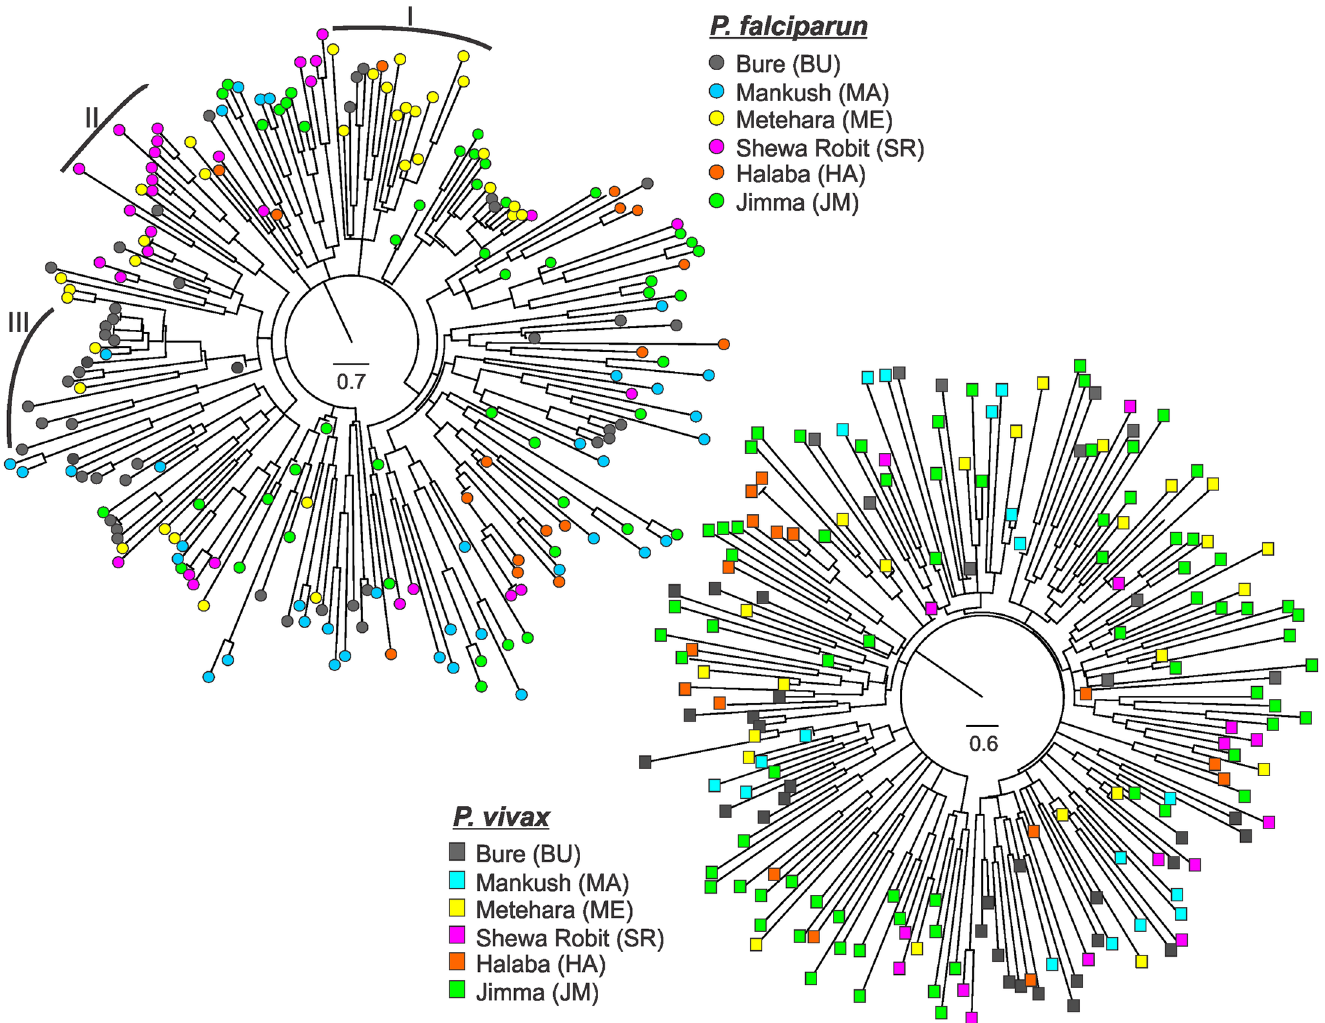
Fig 3. Neighbor-joining trees showing the genetic relatedness among Plasmodium falciparum and P . vivax samples. (A) Genetic relatedness among P . falciparum samples from the six study sites, shown by different color circle. Subclade-Irepresents a genetic cluster of samplespredominantly from Metehara that were closely related; subclade-II represents a cluster of samples predominantly from Shewa Robit; and subclade-III represents a cluster of samples predominantly from Bure. (B) Genetic relatednessamong P . vivax samples from the six study sites, shown by different color